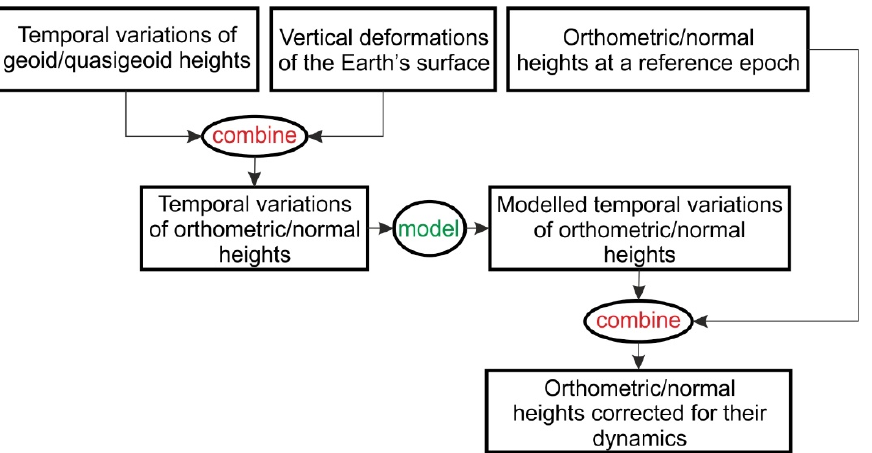
Figure 2. Flowchart describing the general steps to determine orthometric/normal heights corrected for their dynamics.